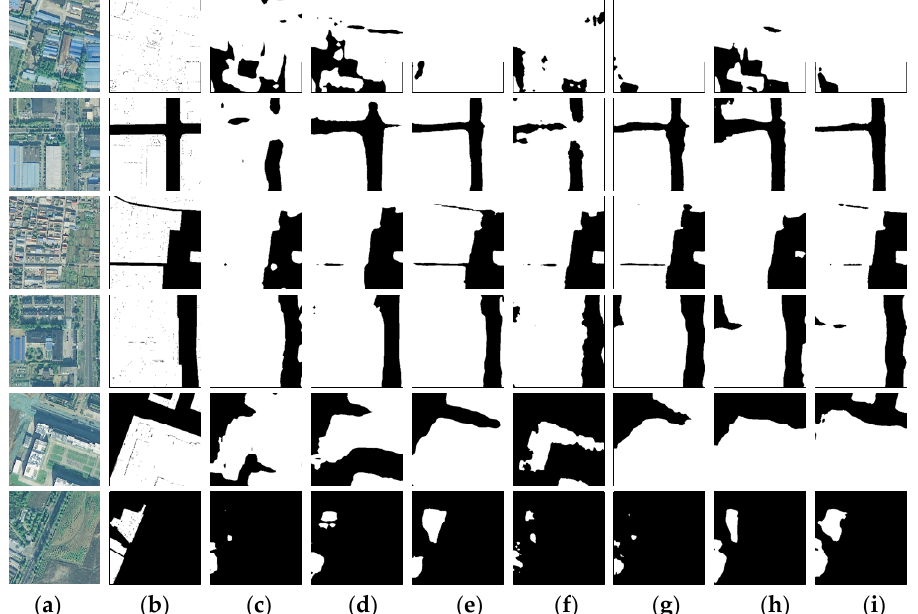
Figure 13. Results obtained by different semantic segmentation methods on the Beijing Huairou district land survey dataset, ( a ) 2019 image, ( b ) 2019 ground truth, ( c ) PSPNet, ( d ) DeepLabV3, ( e ) OCRNet, ( f ) Segformer, ( g ) SwinTransformer, ( h ) UNet(ResNet50), and ( i ) UNet(EfficientNet ‐ b1).